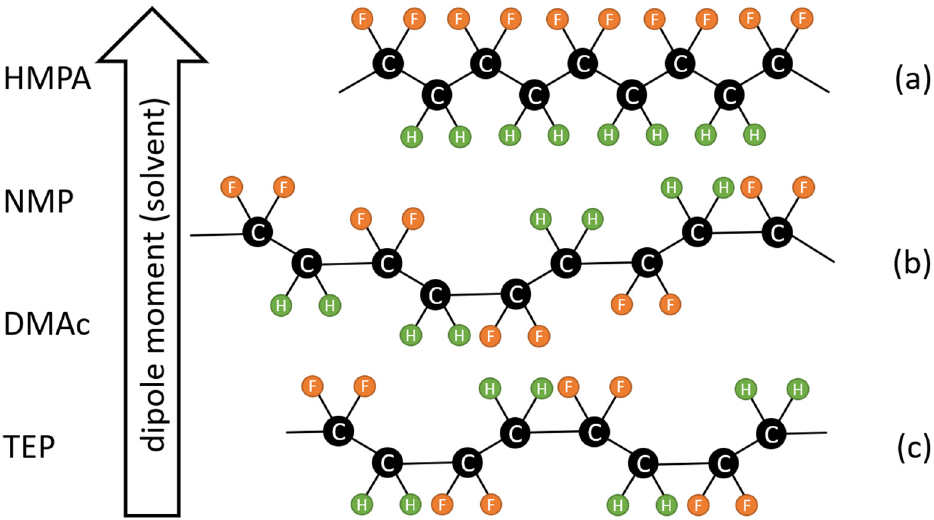
Figure 1. Relationship between PVDF chain conformation and the dipole moment of solvent. PVDF is inclined to form a more polar solution state conformation as it dissolves in a solvent with a higher dipole moment. ( a ) All tans (TTTT); ( b ) TTTG; and ( c ) TGTG ′ .